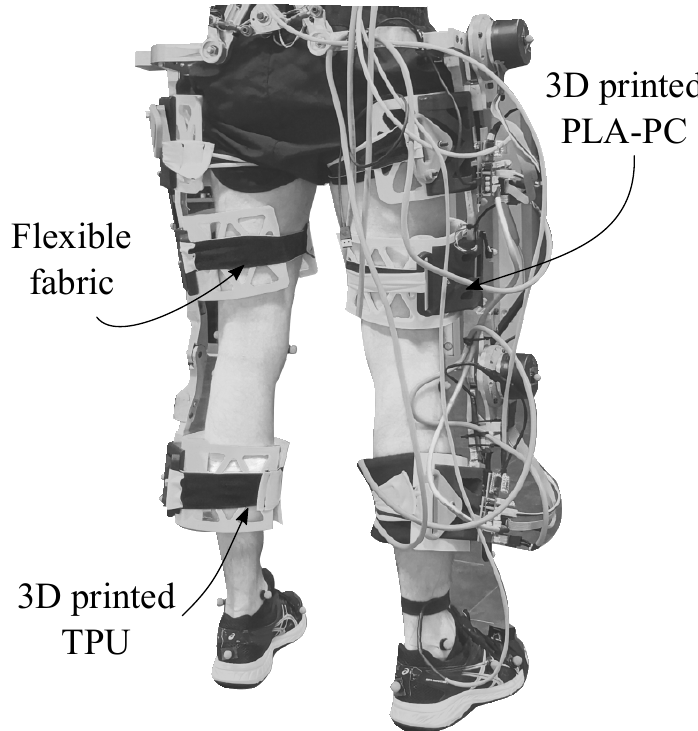
Figure 1. The AGoRA exoskeleton. Uni-lateral actuation on the right